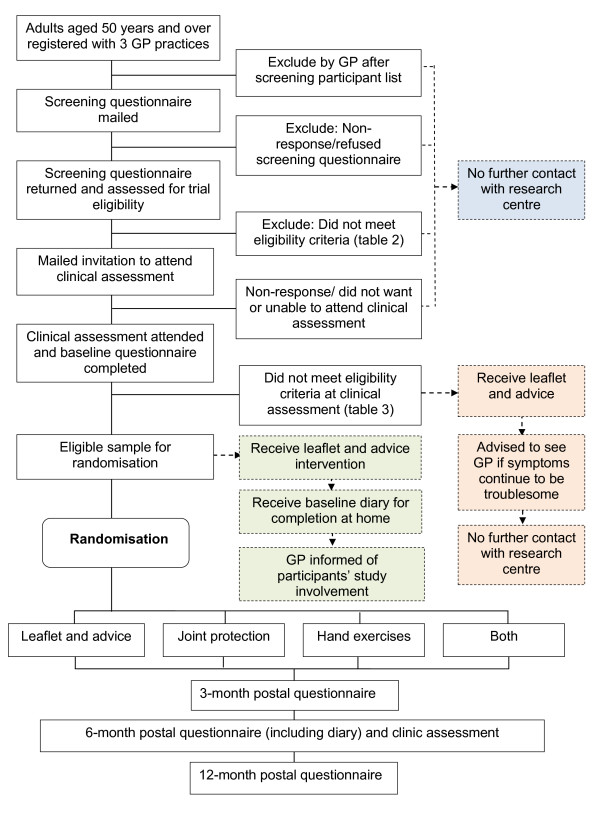
Recruitment flow chart.